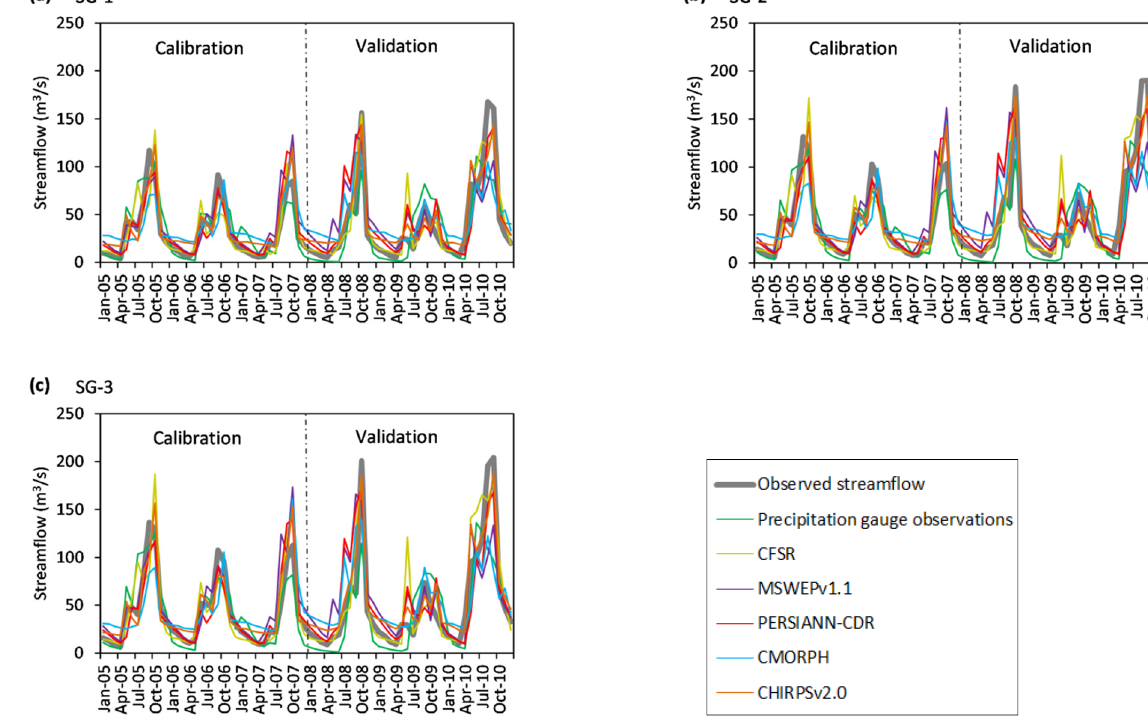
Figure 9. Comparison of simulated streamflow for different precipitation sources and observed monthly streamflow using model parameters calibrated for each dataset in ( a ) SG-1, ( b ) SG-2, and ( c ) SG-3.